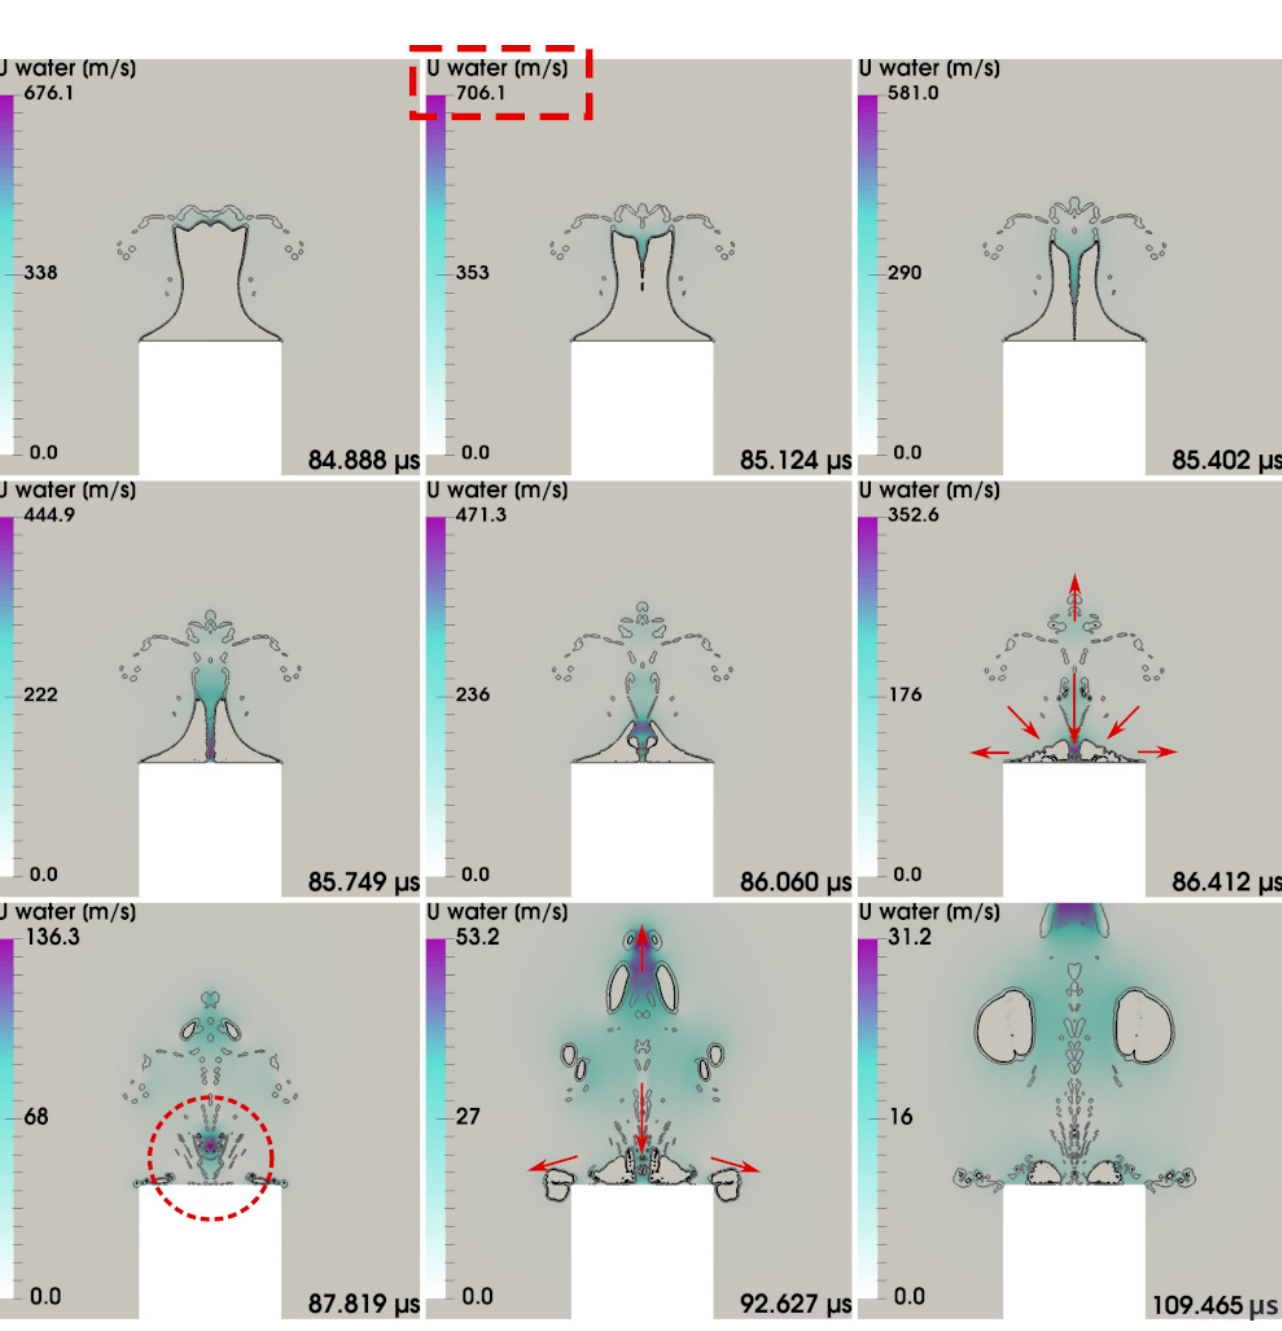
Figure 15. General dynamics of the mushroom bubble, part 2 ( R max,unbound = 472.57µm, D ∗ = 0.063, r ∗ p = 0.423, T Rc = 42.90µs): fast jet formation, bubble collapse and rebound, plotted with the modulus of the liquid velocity field. The red arrows indicate the essential directions of the flow field. The fast jet in this case reaches more than 700m/s (see dashed rectangle on top of the velocity scale in frame 2). The dashed red circles in the lower left frame denote the region, from where shock waves are emitted. Cylinder radius is